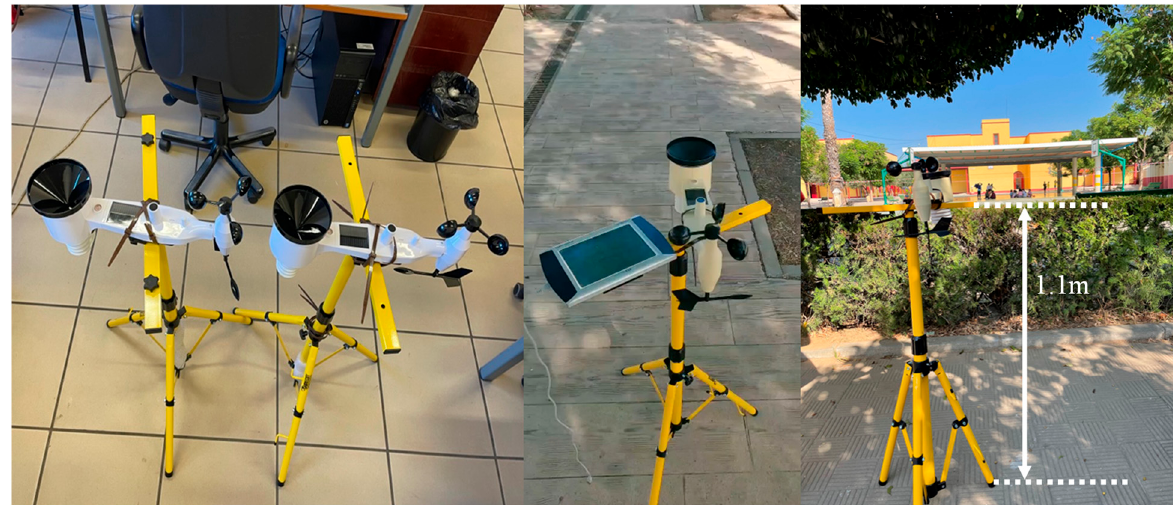
Figure 8. Climatic station on a tripod (semi-mobile monitoring).